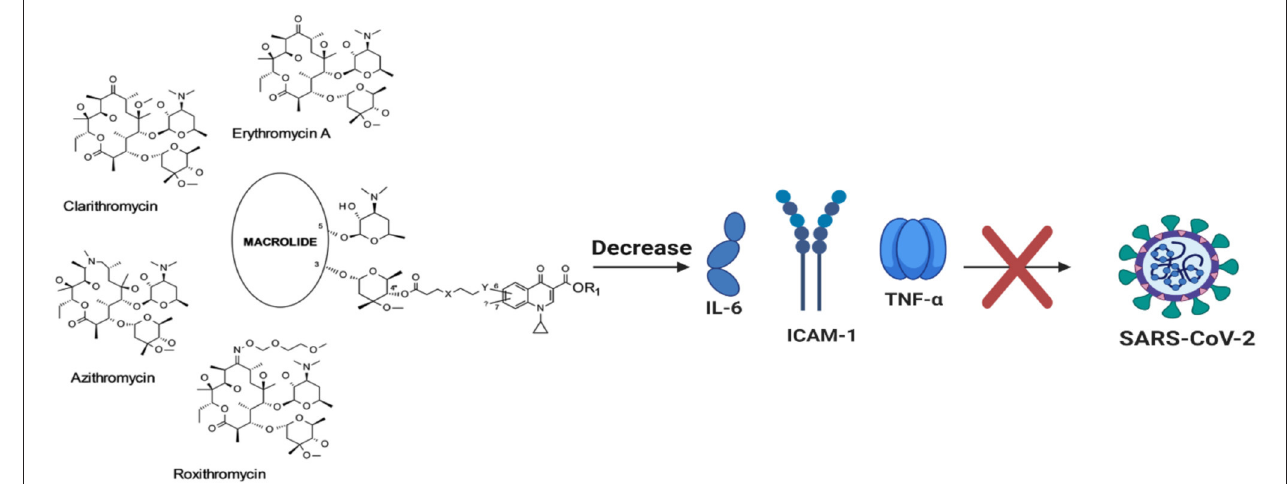
FIGURE 1 | Antiviral effect of